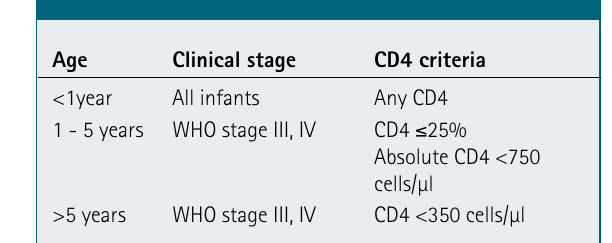
TABLE II. CRITERIA FOR ART